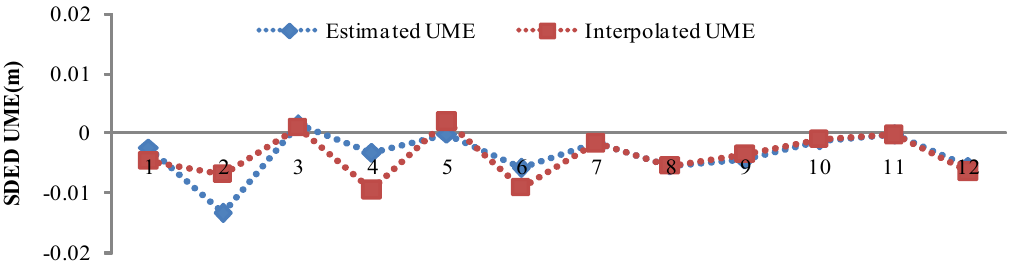
Figure 4. SDED un-modeled errors of SHBS using satellite pair of PRN20 and PRN28,